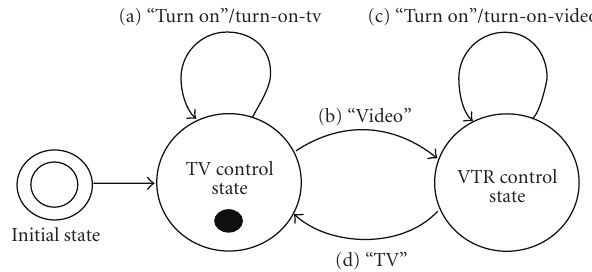
Figure 1: Example of state-transition model.